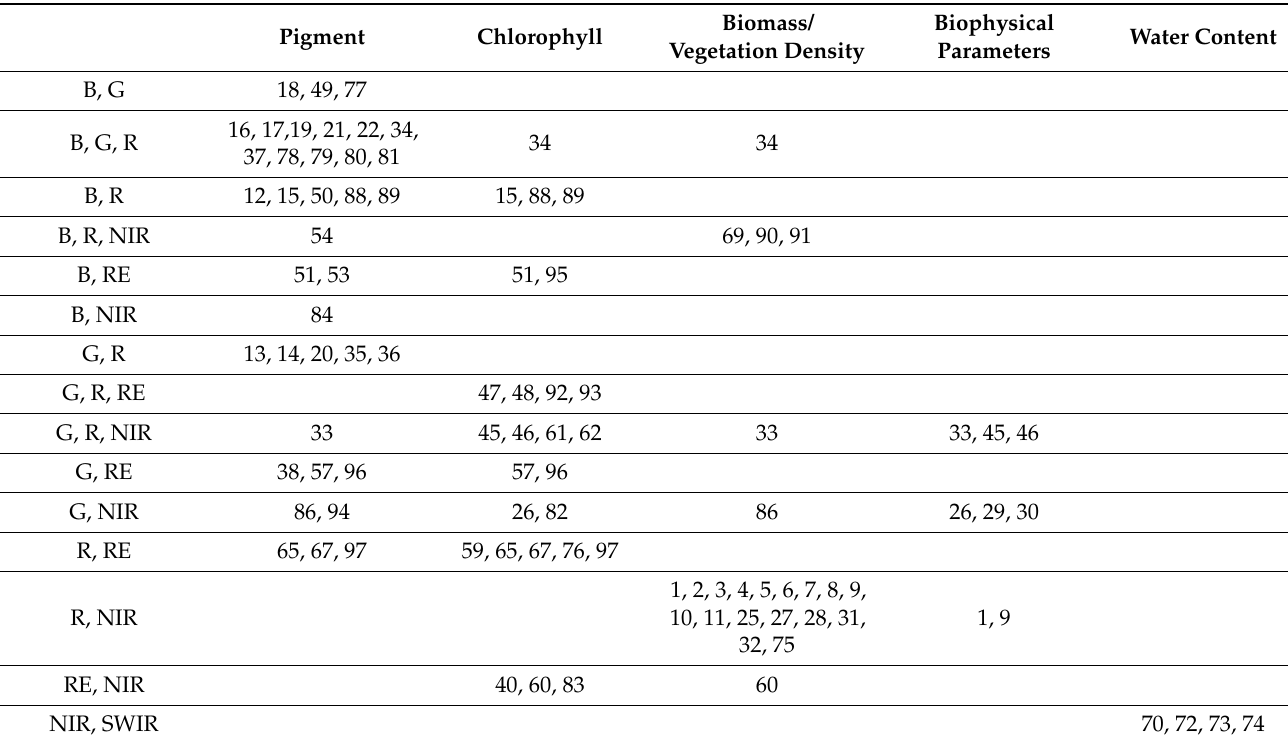
Table 3. ID of Vegetation indices cross-table of categories and spectral bands (B = blue, G = green, R = red, RE = red-edge, NIR = near infrared, SWIR = short wave infrared).